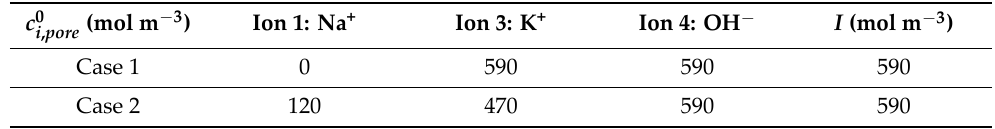
− 3 (mol dm ). i , pore = 0 (concentration of Cl − is zero). 2, pore